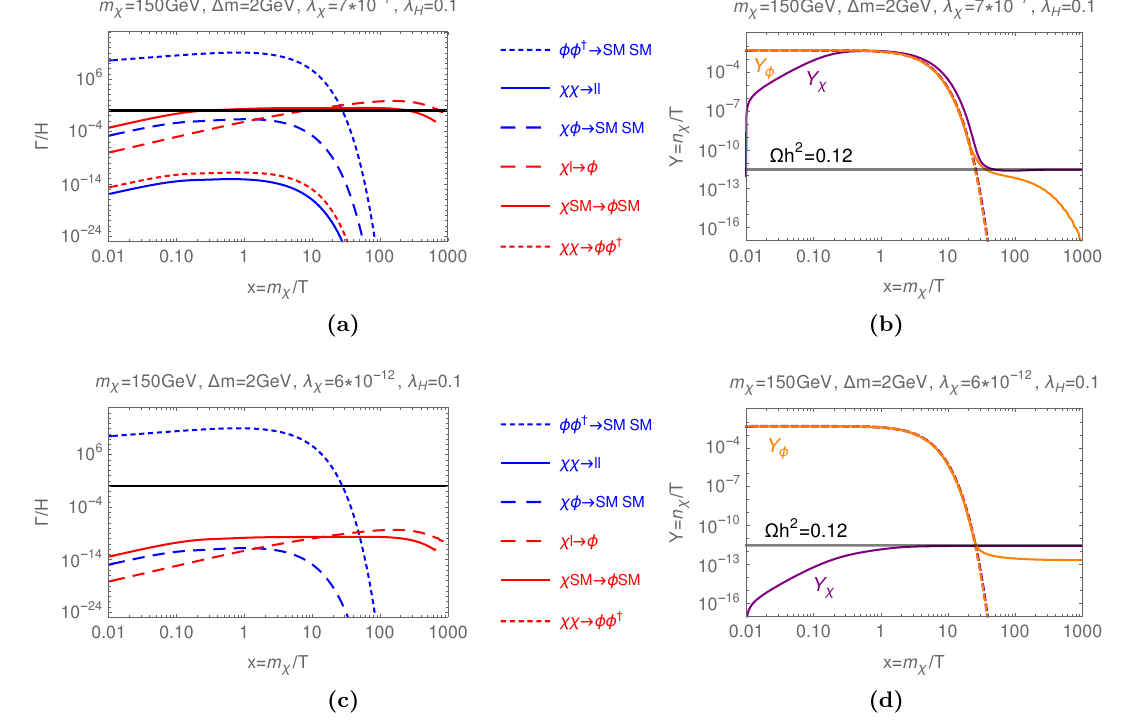
Figure 3 . Benchmark points of figure 2 giving rise to Ω h 2 = 0 . 12. Left: ratio of the rates of interactions depicted in the legend and of the Hubble rate as a function of x = m χ processes are depicted in red, the (co-)annihilation ones in blue. The black line depicts Γ /H = 1. Right: evolution of the yield of χ (solid purple line) and φ (solid orange line) and their equilibrium yield (dashed lines) as a function of x . Notice that, given the small ∆ m the two equilibrium curves (dashed) are almost